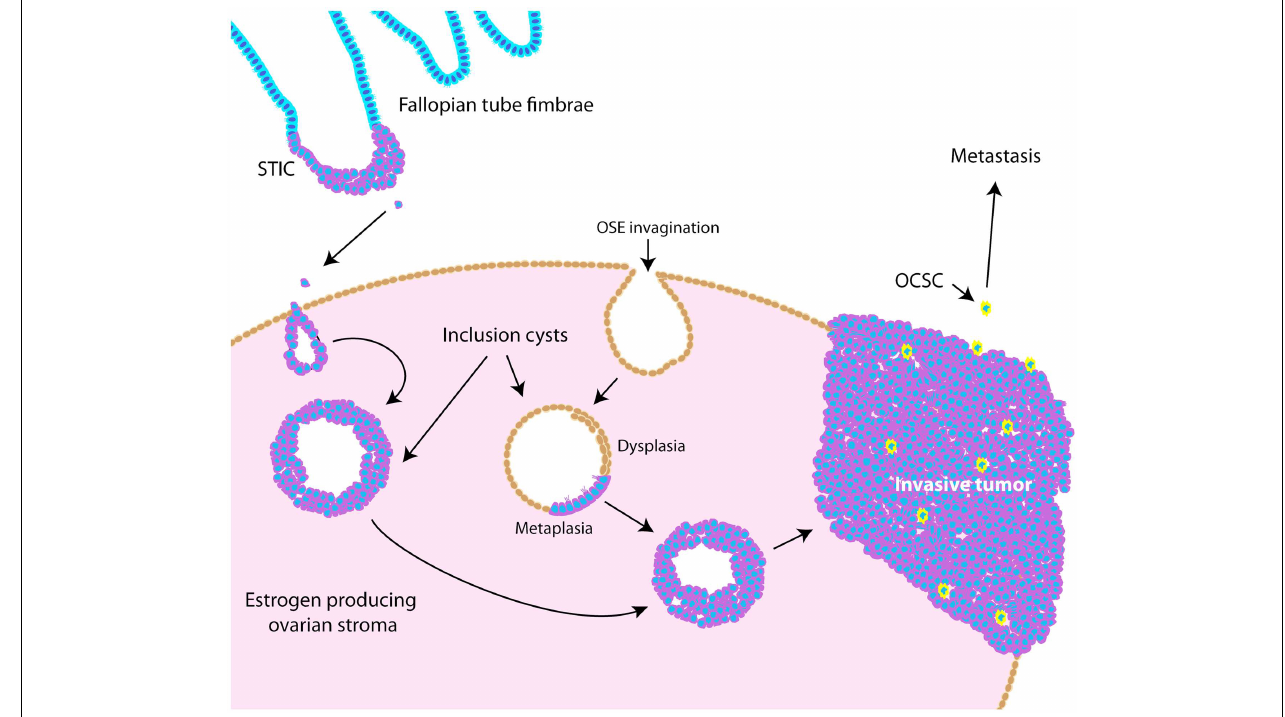
invaginations of the OSE can cause inclusion cysts, which become dysplastic and then undergo metaplasia to resemble fallopian tube epithelium.These cysts can eventually develop into tumors that undergo dedifferentiation as they progress. Ovarian cancer stem-like cells are thought to represent a small proportion of the tumor bulk (illustrated as yellow cells), and are more likely to